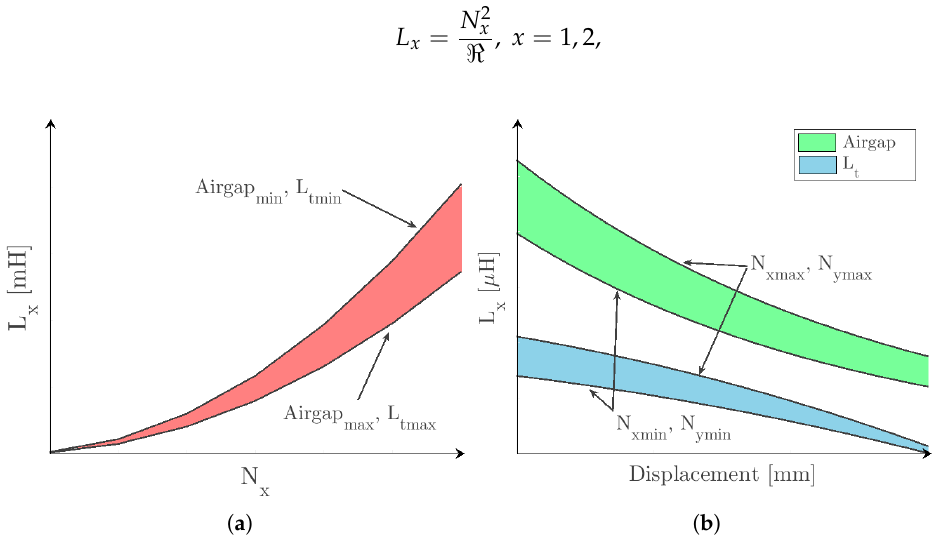
Figure 8. Profiles of L x as a function of N x ( a ), airgap and l t ( b